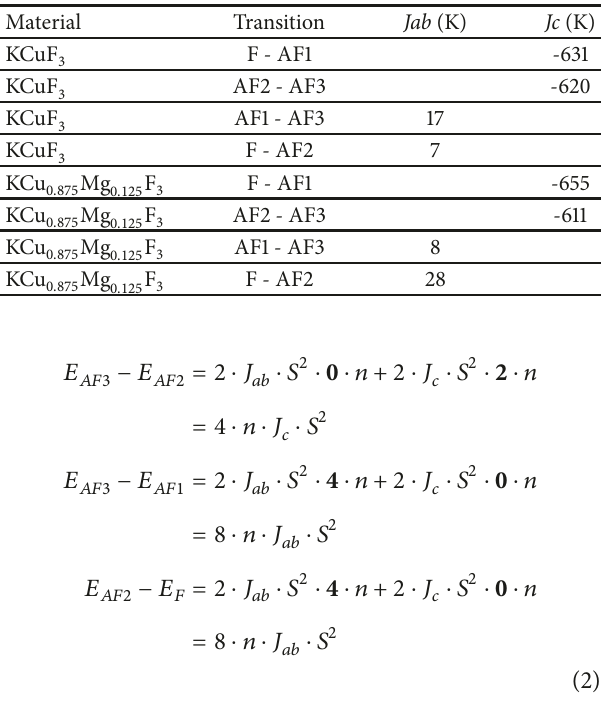
Table 4: Magnetic coupling parameters between Cu pairs in ab planes ( 𝐽 𝑎𝑏 ) and along the c axis ( 𝐽 𝑐